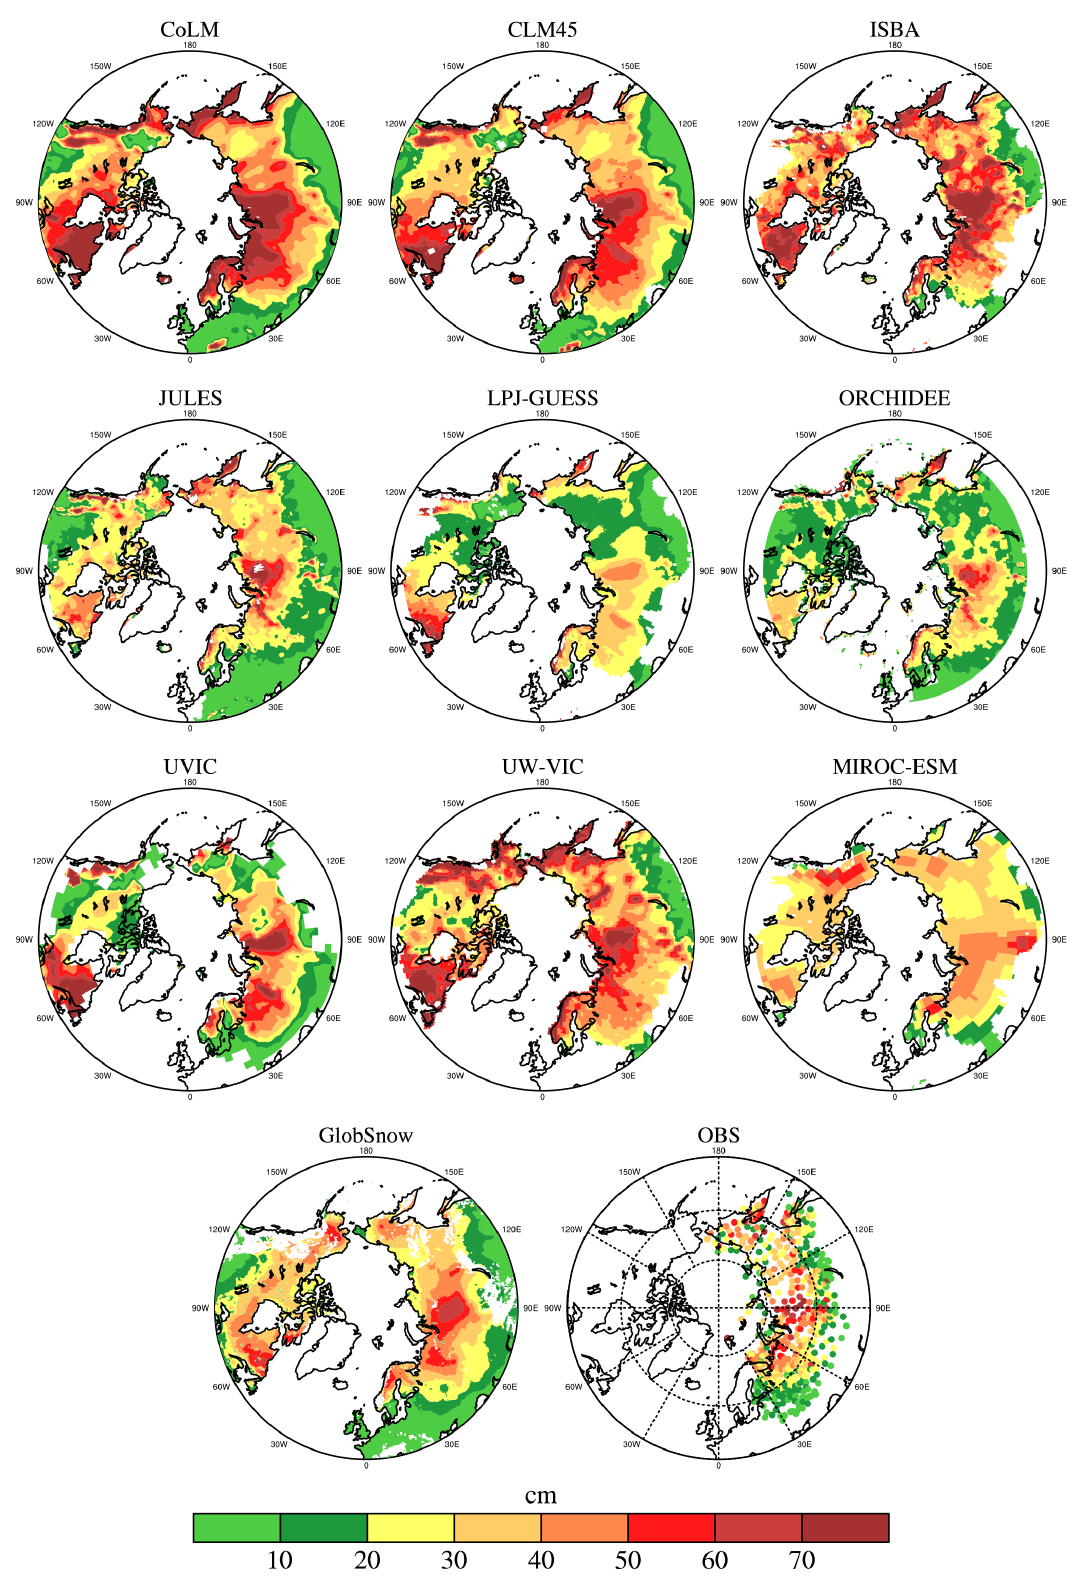
Figure 6. Spatial maps of snow depth (cm) for winter